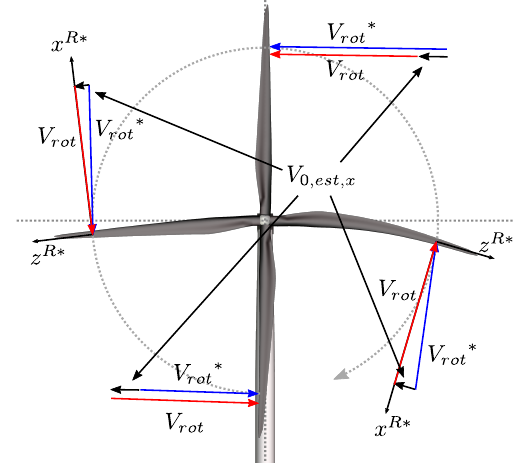
Figure 14. The tower-top deflection angle, θ tt , is unknown in the current method, and therefore the applied transformation matrix, T RG , inaccurately projects a small part of V r onto V G r,z . The result is the small negative offset in the z component in Fig.